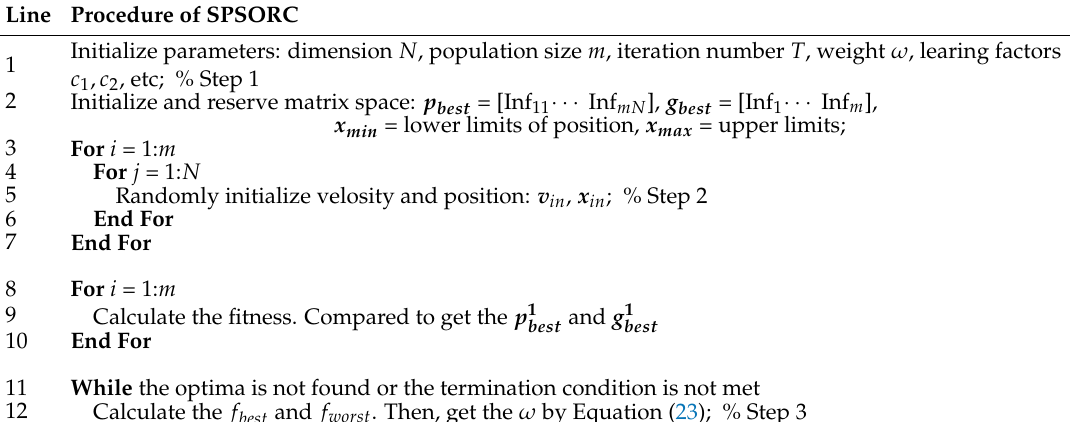
Table 1. The procedure of